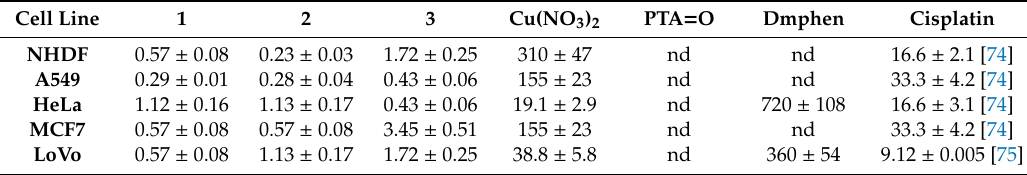
Table 2. IC 50 values ( µ M) of the tested complexes ( 1–3 ), Cu(NO 3 ) 2 , free ligands, and cisplatin. Cell